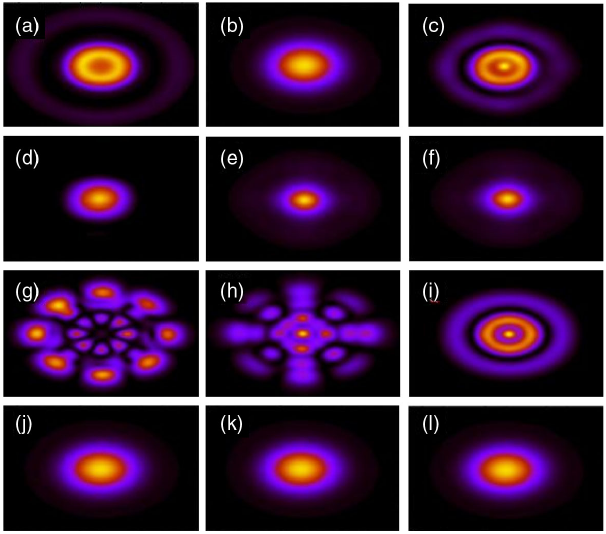
m.FIG. 7. Transverse optical mode as a function of pass number for Gaussian and hollow electron beams for three consecutive passes (60, 61 and 62). (a), (b), (c) and (g), (h), (i) are for the Gaussian electron beam and at wavelengths of 10 and 25 μ m respectively, while (d), (e), (f) and (j), (k), (l) are for the hollow electron beam and at wavelengths of 10 and 25 μ m respectively. In all cases g ¼ − 0 . 6 . The scale for all the plots are from − 23 to 23 mm in both x and y